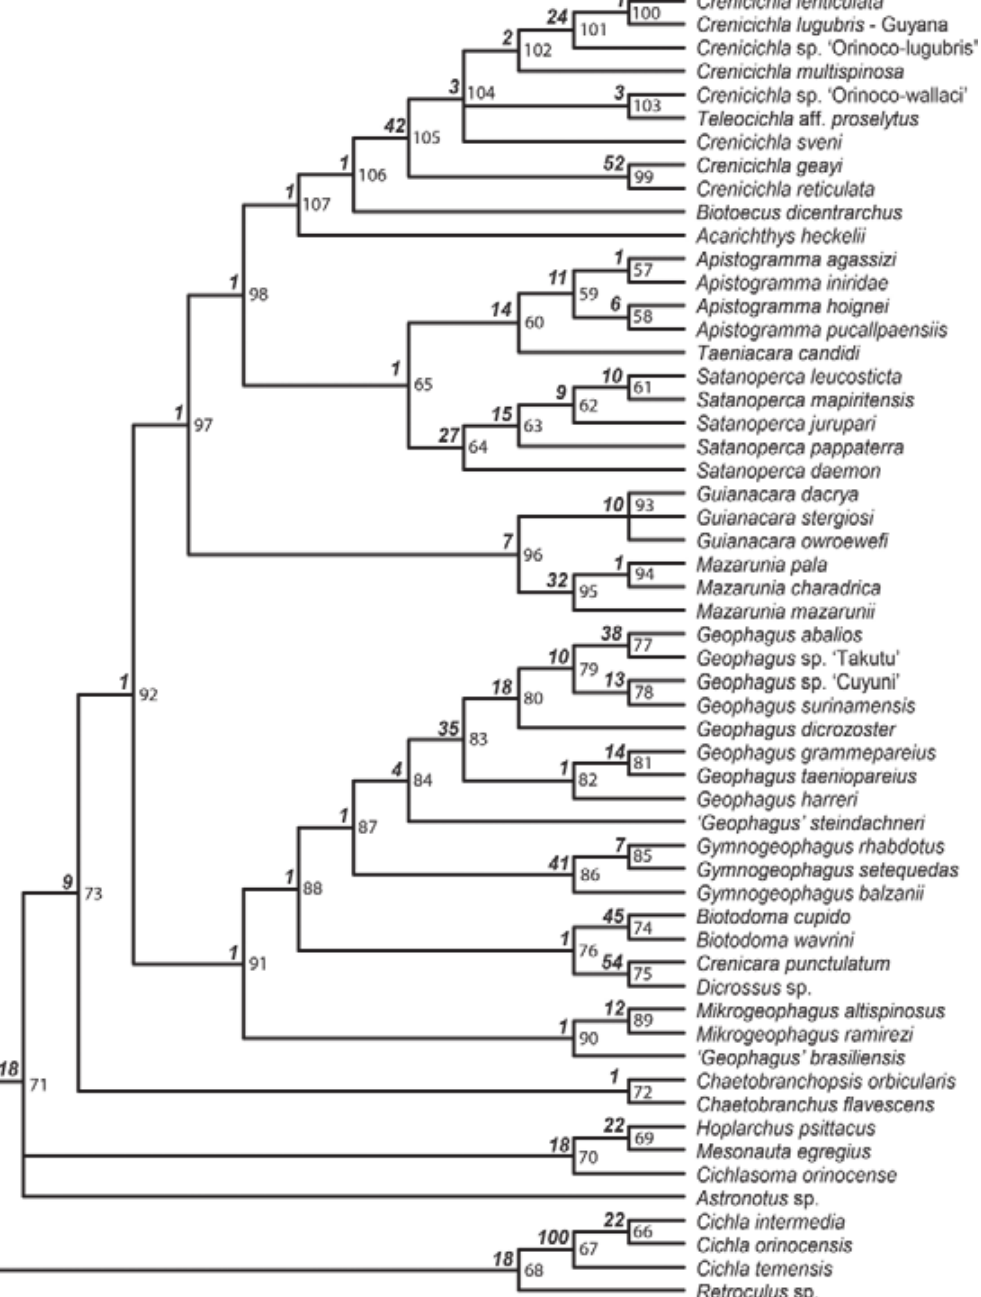
Fig. 1. Strict consensus tree of 8 most parsimonious trees 11073 steps obtained through combined analysis of 3868 base pairs from five loci and 136 morphological characters for 56 taxa. Consistency Index = 0.30, Retention Index = 0.50, Re-Scaled consistency index = 0.15; Decay Index values indicated by each node. See Materials and Methods